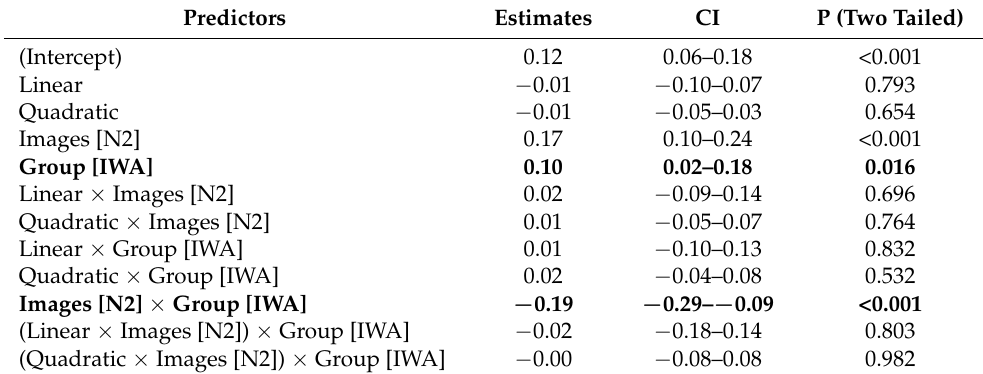
Table A3. Results of GCA analysis for time window 4.